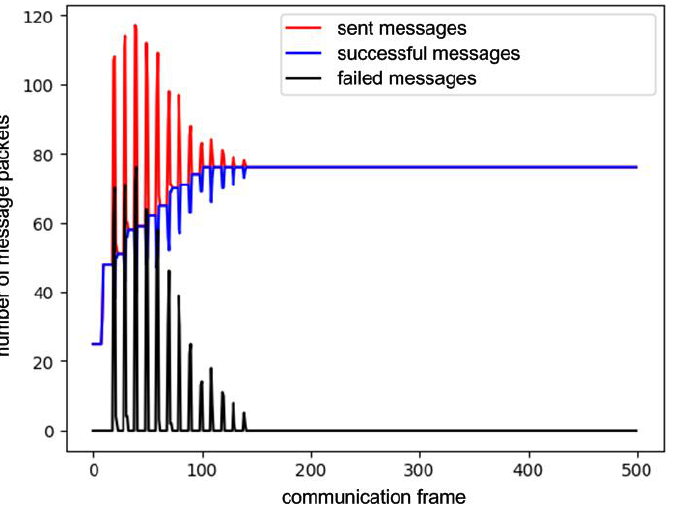
Figure 8. Communication results in each frame. “sent messages” denotes the total number of message packets sent by sensor nodes in the whole network in a frame. “successful messages” indicates message packets successfully received by all nodes within the communication range, and “failed messages” indicates message packets not successfully received by all nodes within the communication range because of communication collisions. Note that there is a case where a message packet is received successfully by some neighbors, while a collision happens with other neighbors; we treat this message packet as failed to be